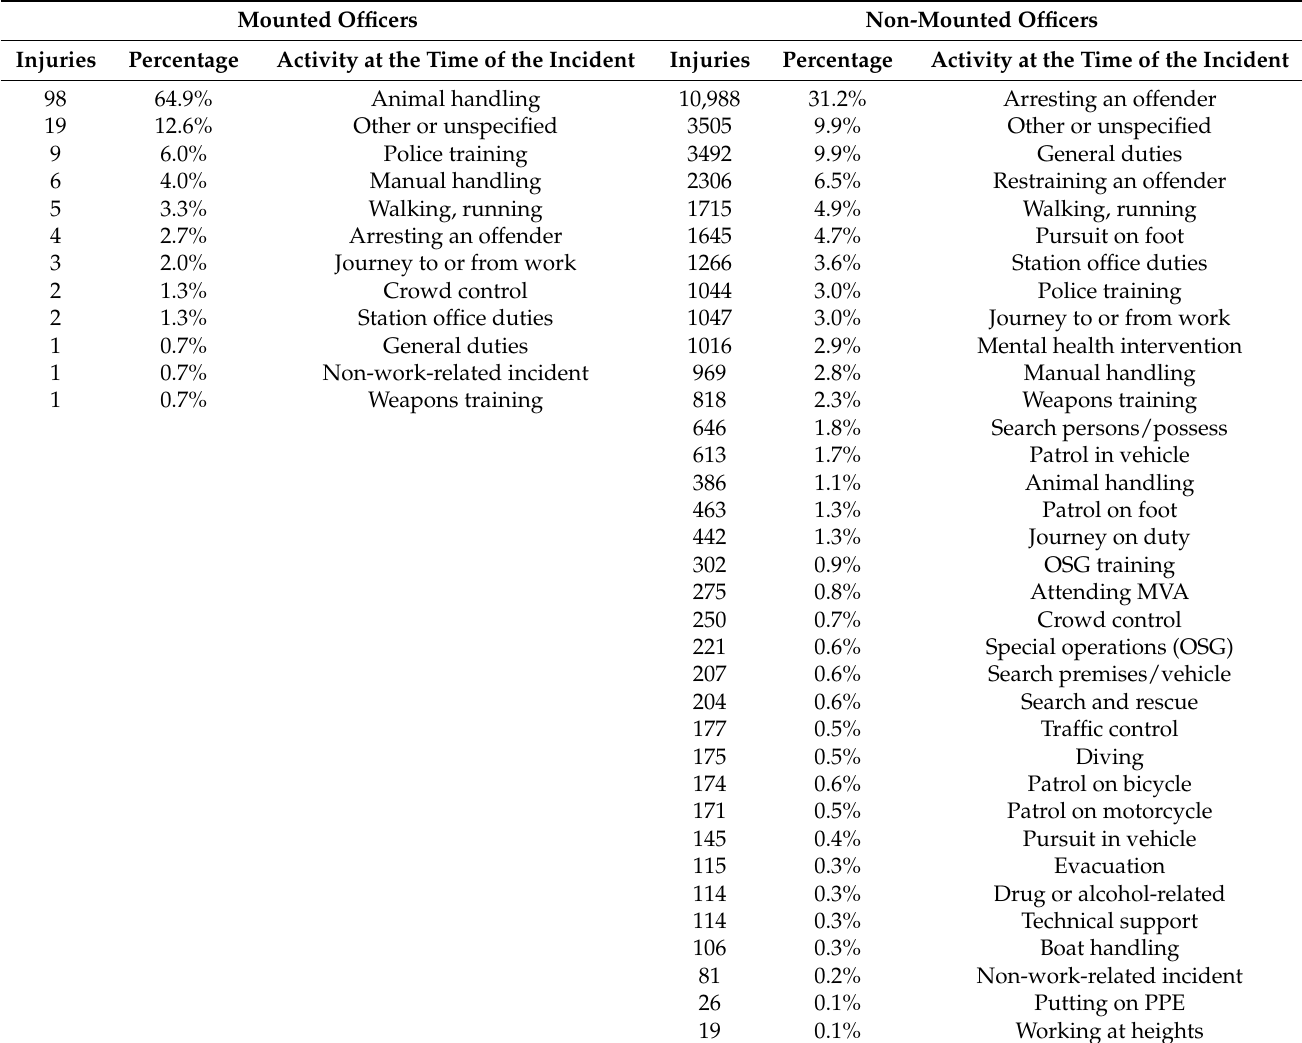
Table 2. Injuries by reported activity at the time of the